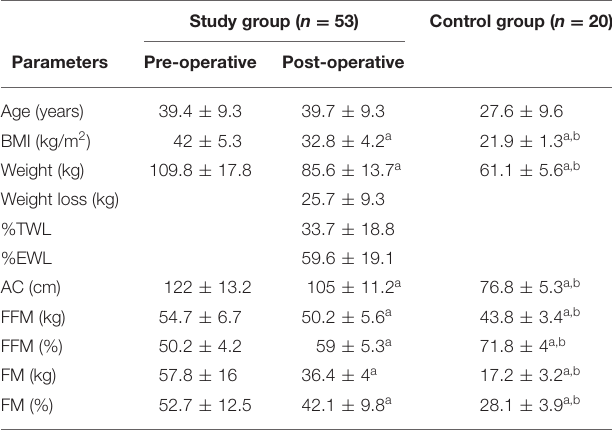
TABLE 1 | The study group’s age, anthropometric characteristics, and body composition in pre- and post-operative periods and control